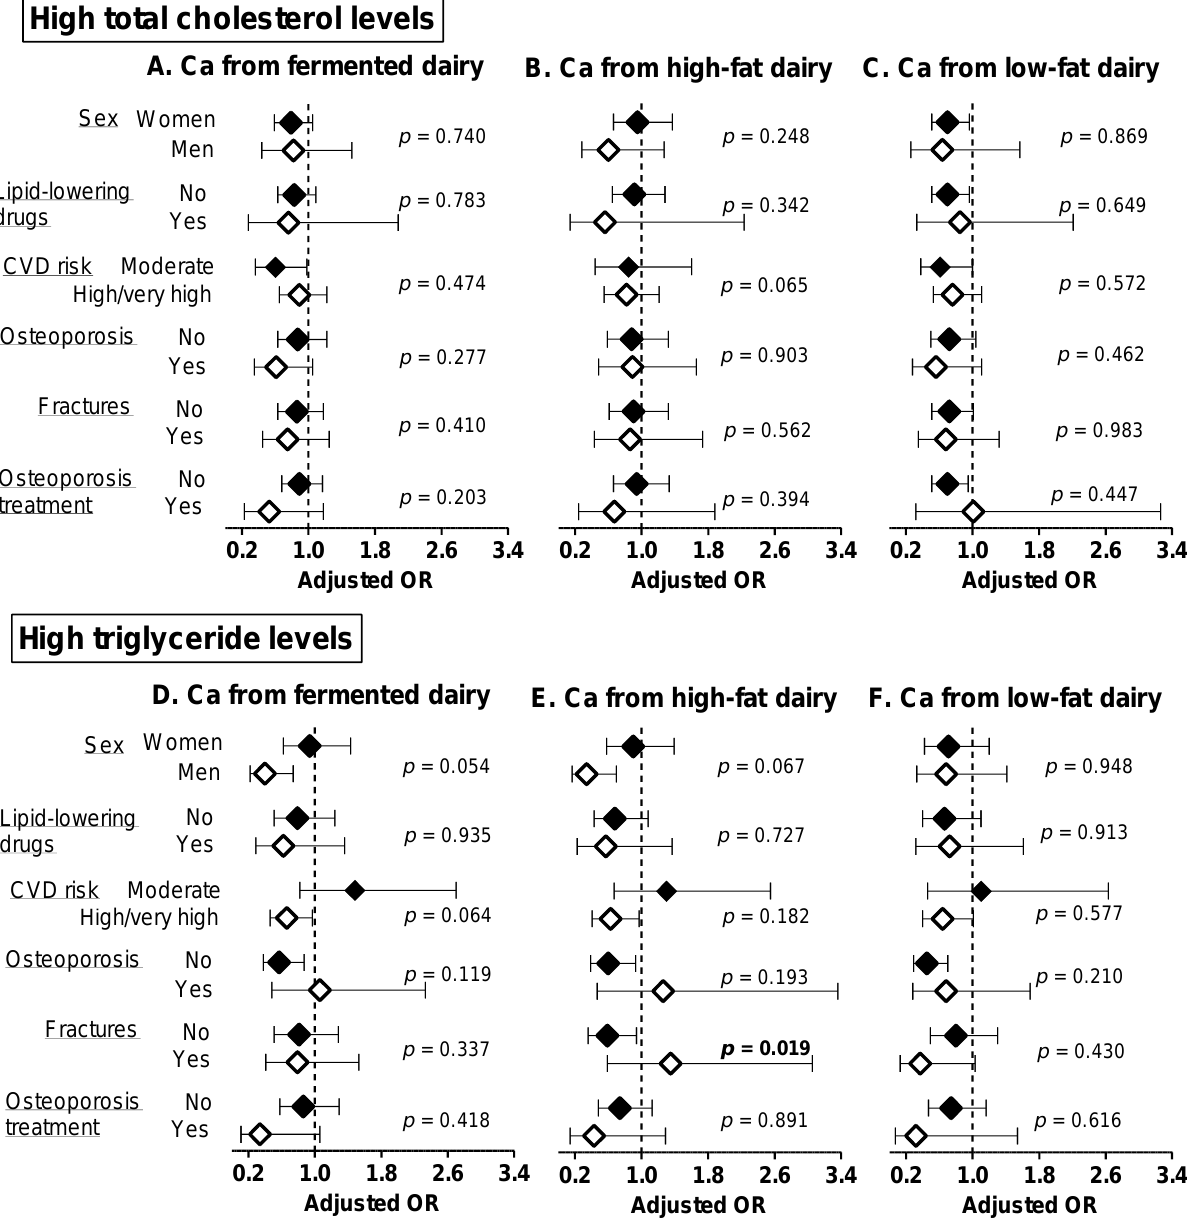
Figure 1. Sensitivity analyses: adjusted ORs and 95 CIs for having high total cholesterol ( A – C ) and triglyceride ( D – F ) levels per 300 mg increase in calcium intake from fermented, high and low-fat dairy products. The models were adjusted for age, sex, weight, height, smoking status, alcohol intake, dietary energy intake, physical activity energy expenditure and use of medication (statins or other lipid-lowering drugs, antihypertensive drugs, antidiabetic drugs). p -values refer to the interaction of each calcium from fermented/high-/low-fat dairy products and the stratifying variable. Significant p -values (<0.05) are indicated in bold. Ca: calcium, CVD: cardiovascular disease, TG: tri- glycerides.